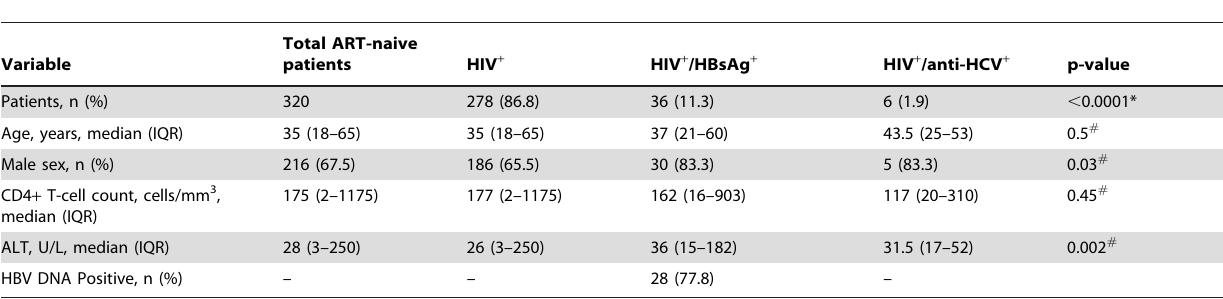
Table 1. Baseline characteristics of HIV/HBV co-infected (HIV + /HBsAg + ), HIV mono-infected (HIV + ) and HIV + /anti-HCV + patients.